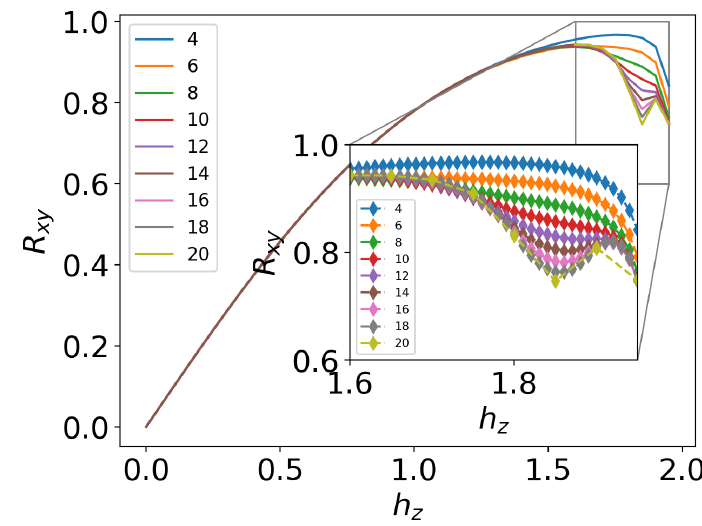
Figure 3: The compatibility index R = 0.2 as a function of the longitudinal field h h x the compatibility index near the critical